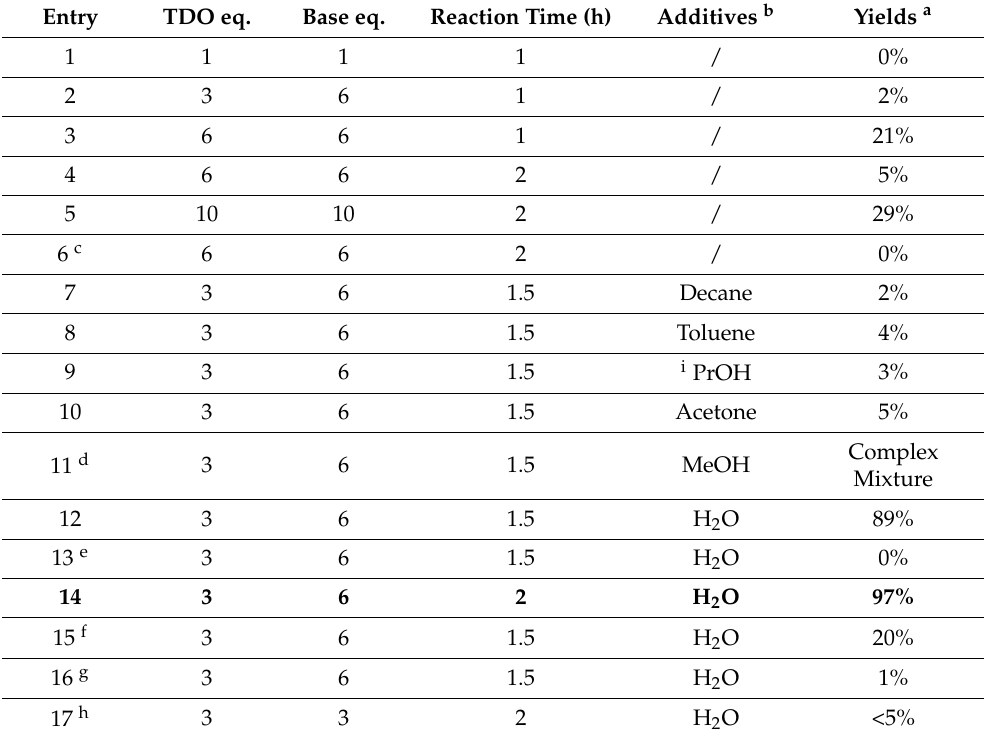
Table 1. Optimization process for the reduction of 2a to 3a . Entry TDO eq. Base eq. Reaction Time (h) Additives b Yields a